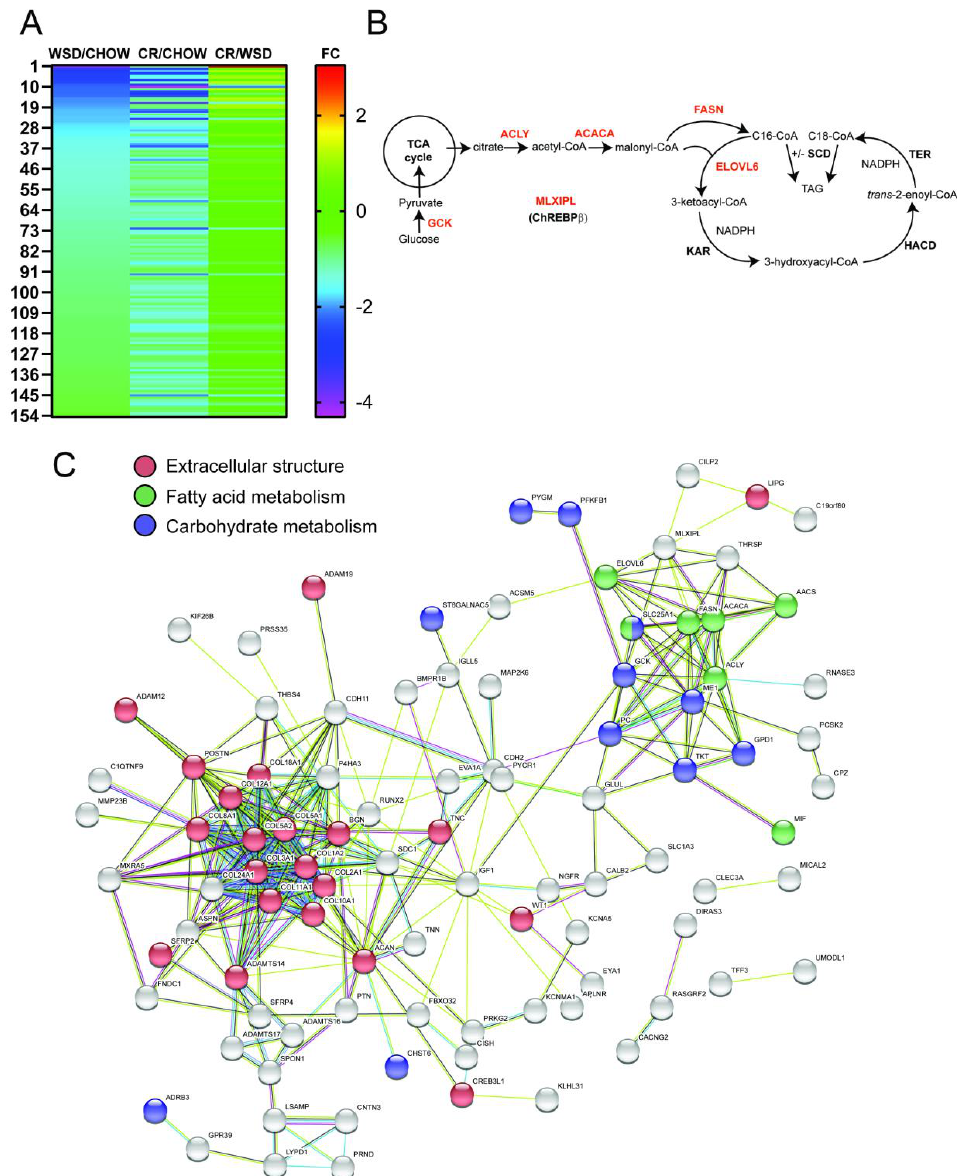
Figure 3. Western-style diet (WSD) causes sustained downregulation of de novo lipogenesis (DNL) genes in subcutaneous white adipose tissue (SC-WAT). Three SC-WAT biopsies collected at the end of each dietary period were subjected to the RNA-Seq transcriptional analysis. This figure describes a subset of differentially expressed genes (DEGs) that were downregulated after WSD and remained downregulated following caloric restriction (CR). ( A ) Heat map of DEGs (the number of genes of this category is indicated); FC, log2fold changes in gene expression. ( B ) DNL pathway; enzymes and transcription factors are in red: glucokinase (GCK), ATP-citrate lyase (ACLY), acetyl-CoA carboxylase (ACACA), fatty acid synthase (FASN), carbohydrate-responsive-element-binding protein-beta (MLXIPL/ ChREBPβ , the transcriptional regulator of DNL). DNL-derived palmitate (C16) is elongated (C16 − > C18) by elongation of very long chain fatty acids protein 6 (ELOVL6). C16 and C18 are desaturated by stearoyl-CoA desaturases (SCD). Additional enzymes regulating fatty acid elongation: 3-ketoacyl-CoA reductase (KAR), trans-2-enoyl-CoA reductase (TER), 3-hydroxyacyl ACP dehydrase (HACD); TAG, triacylglycerol. ( C ) STRING Functional Protein Network Analysis of downregulated DEGs reveals functional connectivity associated with fatty acid metabolism / DNL (green), carbohydrate metabolism (blue), and extracellular matrix structure